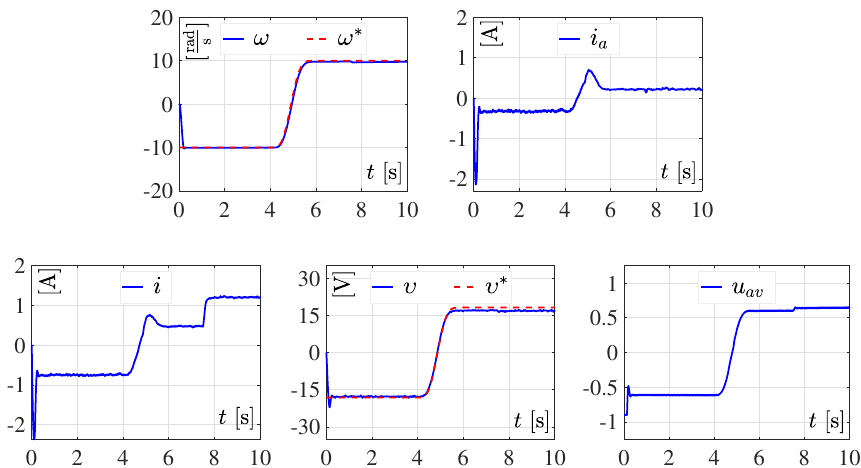
Figure 13. Experimental results associated with the designed flatness-based control (3), when ω ∗ is of the Bézier type (22), and the abrupt variations in load R , declared in (26), are introduced into the system.